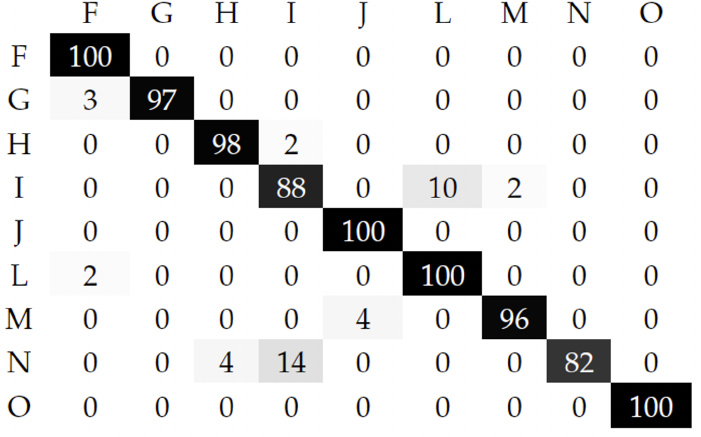
Figure 7. Average rounded confusion matrix (in terms of percentage) for SAR classification using InGaMM-eV for Sentinel-1 wave mode SAR